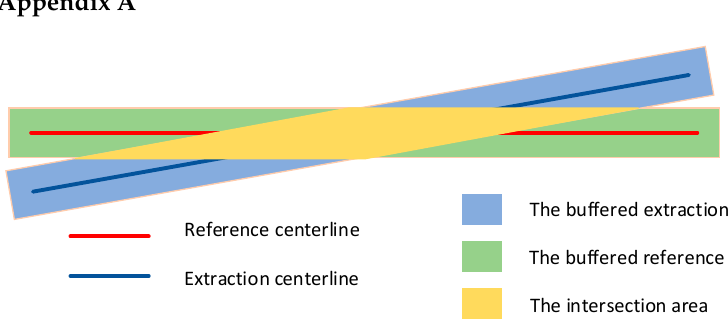
Figure A1. The evaluation of road centerline extraction via buffers.